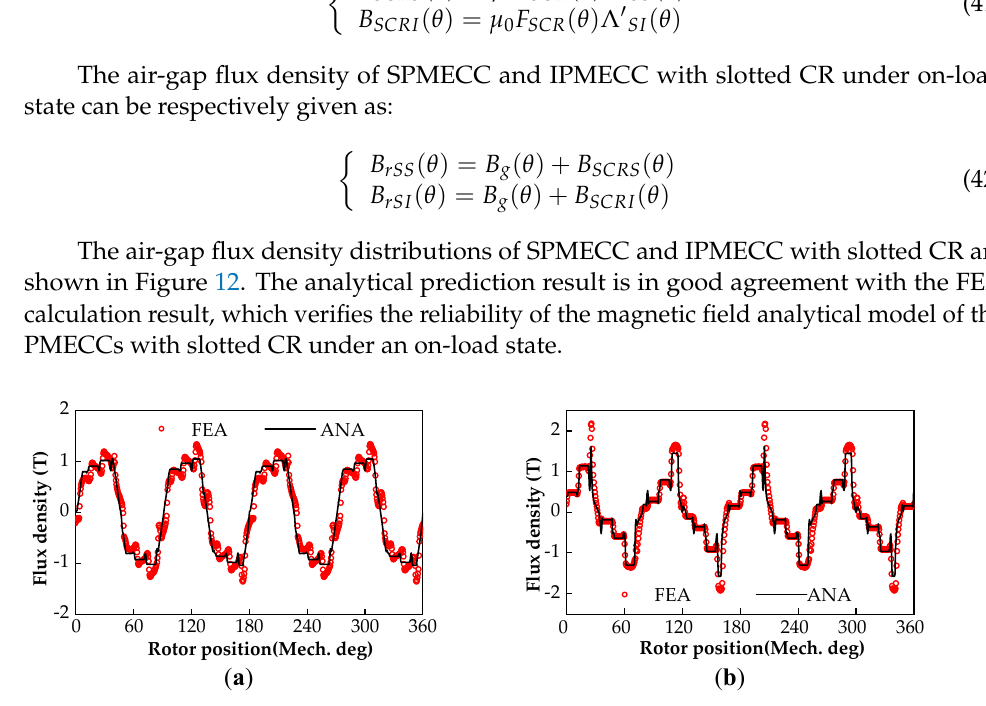
Figure 12. The on-load air-gap flux density of the PMECC with slotted CR (Slip speed is 250 rpm): ( a ) Model − B; ( b ) Model − D.